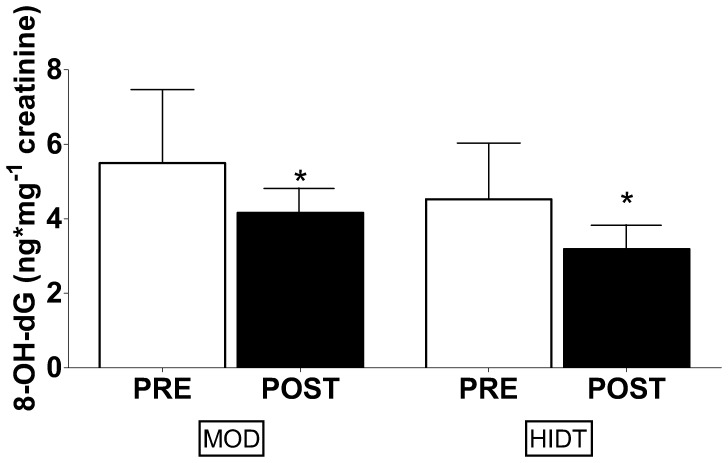
Effect of continuous moderate-intensity training (MOD) and high-intensity discontinuous training (HIDT) on oxidative damage of DNA measured by 8- hydroxy -2-deoxy guanosine (8-OH-dG).White bars represent pre-training (PRE) values and black bars are post-training (POST) values. Values are expressed as means ± SD. * Significantly different from PRE (P<0.05).